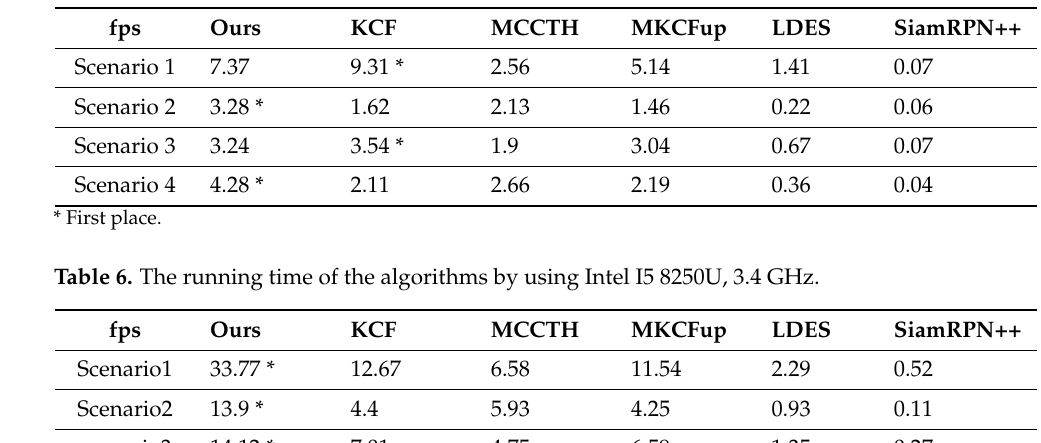
Figure 15. Tracking accuracy using Metrics-1 and Metrics-2: ( a ) tracking accuracy using Metrics-1; ( b ) tracking accuracy using Metrics-2.